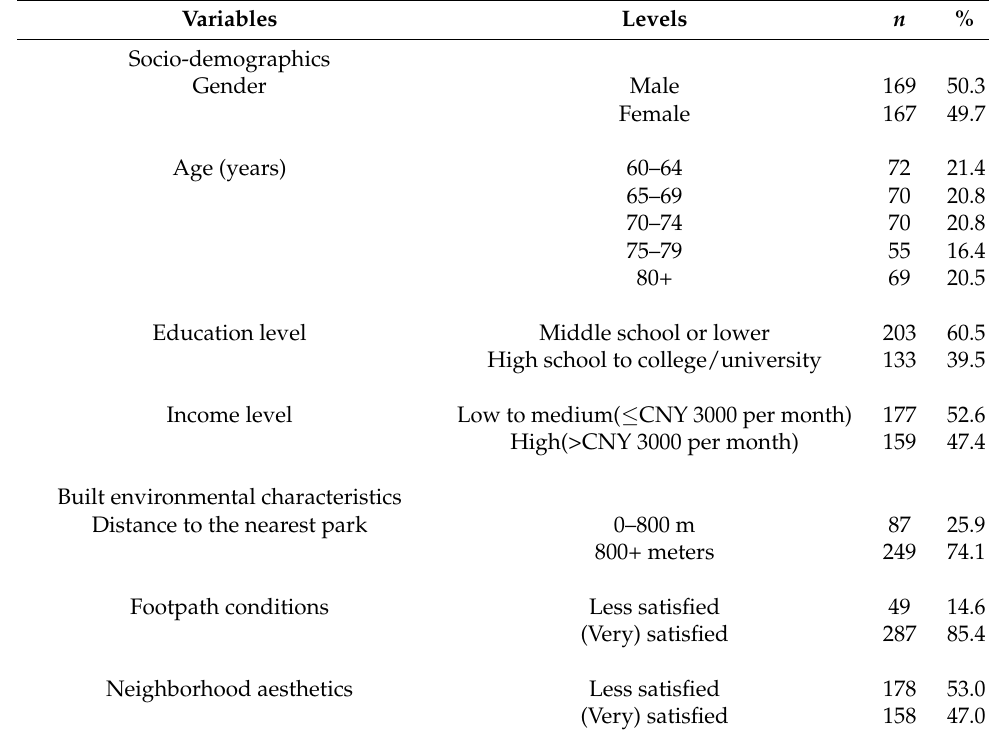
Table 1. Sample characteristics ( n =